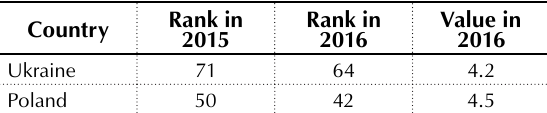
Table 5. The Networked Readiness Index of